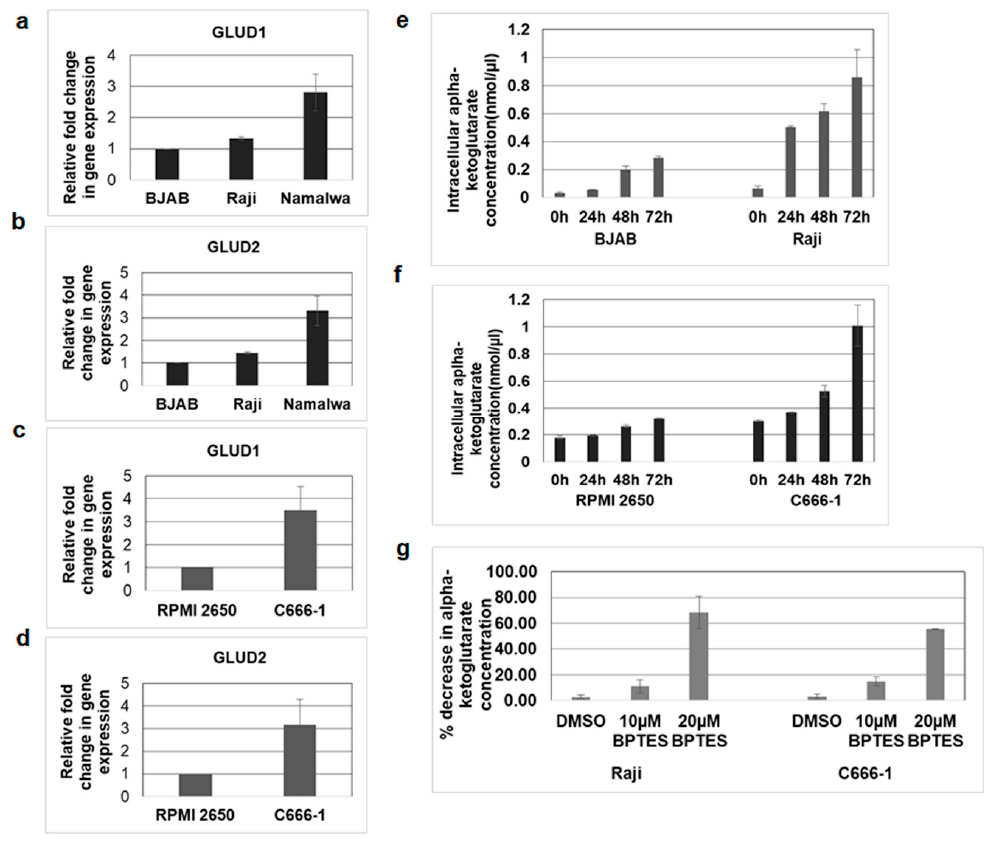
Figure 7. GLUD1 and GLUD2 expression and alpha-ketoglutarate levels increased in EBV-infected cells. ( a ) and ( b ) RNA was isolated from EBV-negative cell line BJAB and EBV-positive cell lines Raji and Namalwa. The expression of GLUD1 ( a ) and GLUD2 ( b ) was analyzed by real-time RT-PCR. ( c ) and ( d ) RNA isolated from EBV-negative cell line RPMI 2650 and EBV-positive cell line C666-1 were examined for GLUD1 ( c ) and GLUD2 ( d ) expression by real-time RT-PCR. The fold change in gene expression was calculated using the ∆∆ CT method and normalized with respect to the expression of GAPDH. Error bars represent the mean ± SD of two independent experiments. ( e ), ( f ), and ( g ) BJAB, Raji, RPMI 2650, and C666-1 cell lines were cultured, and alpha-ketoglutarate concentrations in cell lysates of BJAB and Raji ( e ), RPMI 2650, and C666-1 ( f ) were measured at indicated time points using alpha-ketoglutarate assay kit. The concentration of alpha-ketoglutarate is expressed in nanomoles per microliter. ( g ) Raji and C666 cell lines were treated with control DMSO or 10 µM and 20 µM BPTES. Alpha-ketoglutarate concentration was determined in the cell lysates collected after 72 h. Graphs represent the percentage decrease in alpha-ketoglutarate concentration in Raji and C666-1. Error bars represent the mean ± SD of two independent experiments.